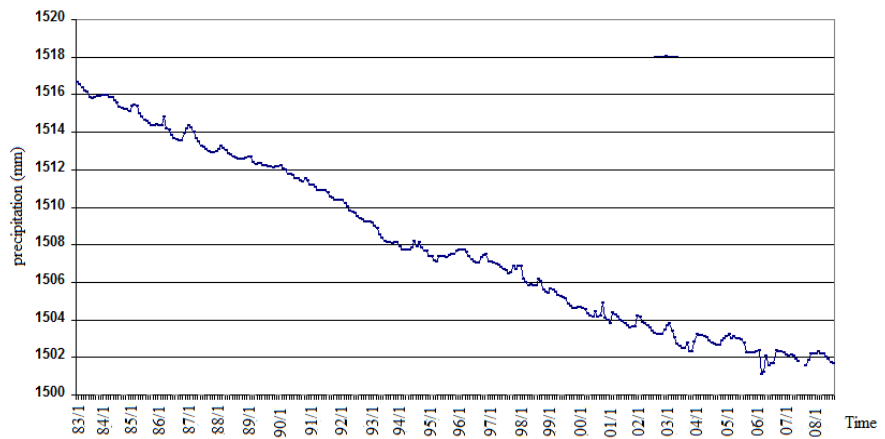
Figure 6. The precipitation amount of the Abarkooh plain from 1983 to 2008 [21].